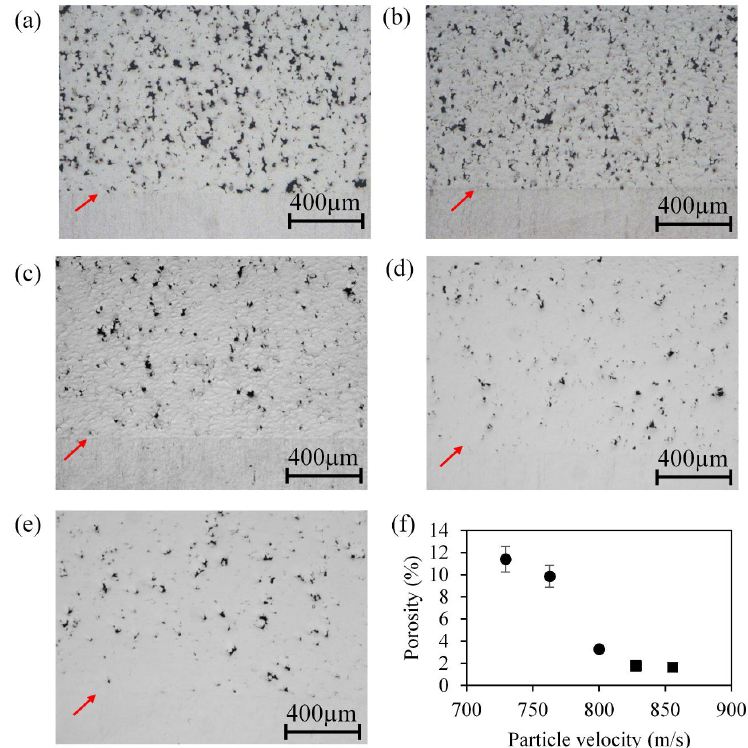
Figure 5. Figure 5. ( a – e ) Optical micrographs of polished cross-sections for the coatings deposited with particle velocities of ( a ) 730; ( b ) 760; ( c ) 800; ( d ) 827 and ( e ) 855 m/s; and ( f ) porosity level as a function of particle velocity. The arrows in ( a – e ) indicate the interfaces between the coatings and